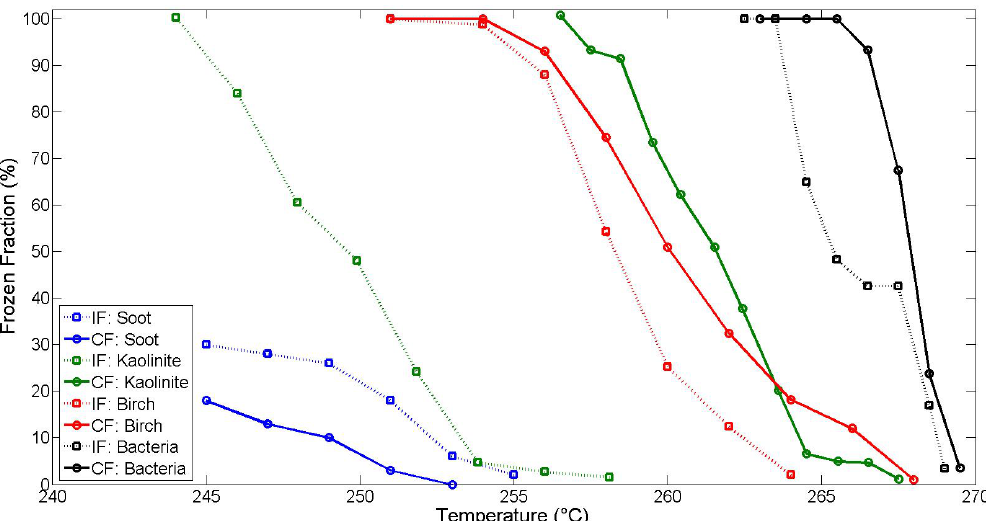
Fig. 13. Comparison of contact freezing (CF) and immersion freezing (IF) results as a function of temperature using different IN. All the experiments were conducted in a wind tunnel. The contact freezing and the immersion freezing experiments are represented by the solid (circles) and dotted (squares) lines respectively. The blue color represent the experiments done with soot particles, green with kaolinite, red with pollen and black with bacteria (Pitter and Pruppacher, 1973; Levin and Yankofsky, 1983; Diehl and Mitra, 1998; Diehl et al., 2002). Note that the collision rates are not accounted for in any of the presented